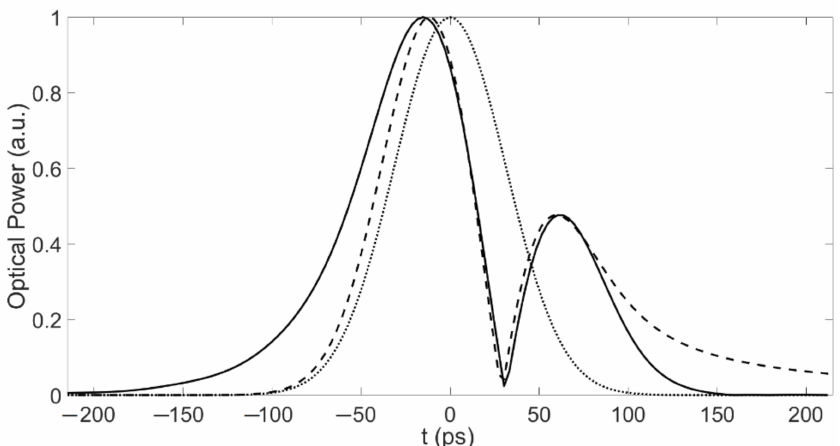
Figure 7. Simulated (solid curve) and ideal (dashed curve) time response of the designed 0.51th-order differentiator. The input signal is also displayed (dotted curve); all signals were normalized to